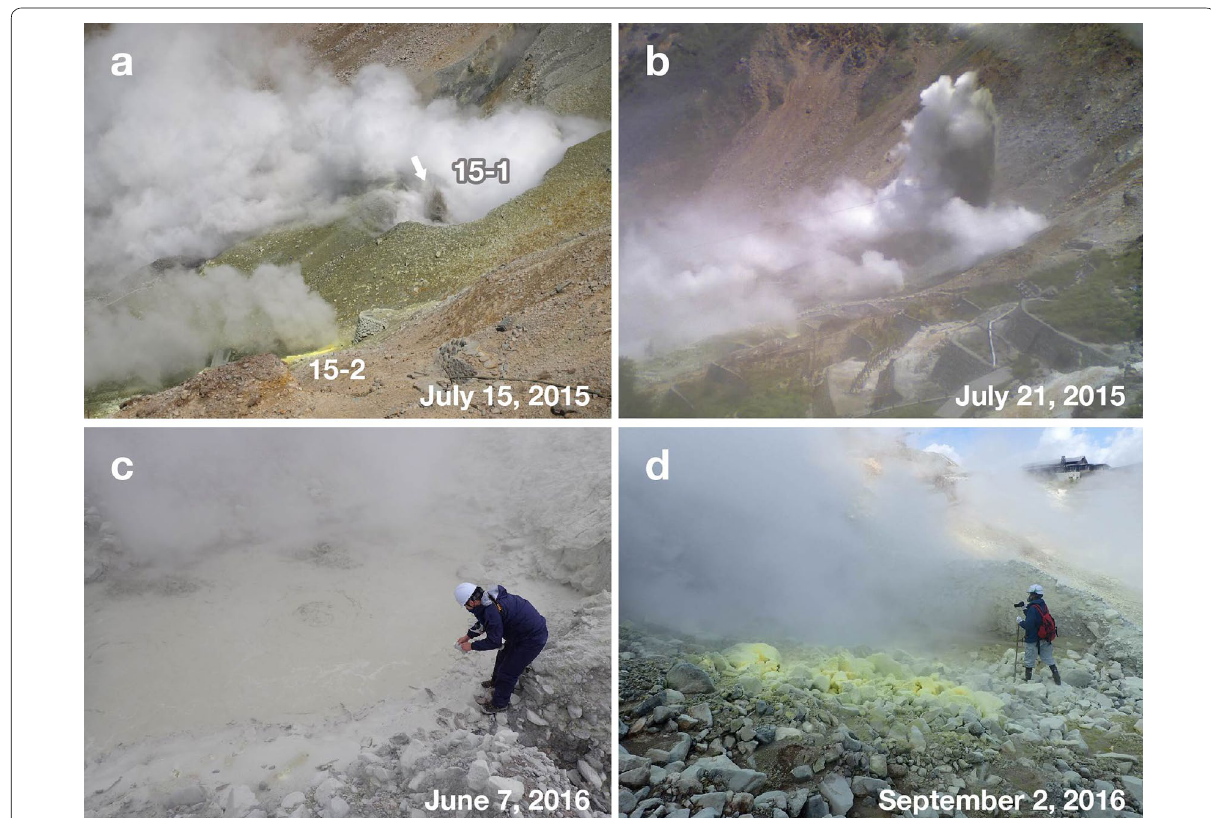
Fig. 17 Sequential change of 15-1 crater. a Soon after the eruption, a mud pool formed in the bottom of the crater and vigorous fountaining of mud (arrow) was observed. b A sudden and transient explosion at 15-1 crater on 12:01 of July 21, 2015. c Boiling mud pool formed within 15-1 crater. d Fumaroles formed after a landslide that took place in August 2016